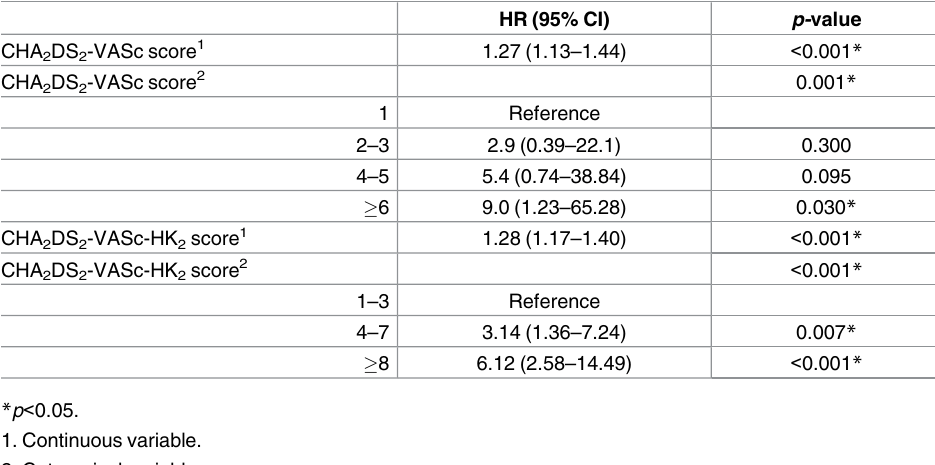
Table 3. Prediction of thromboembolic events in 1,202 heart failure patients in sinus rhythm using the CHA2DS2-VASc score and the CHA2DS2-VASc-HK 2